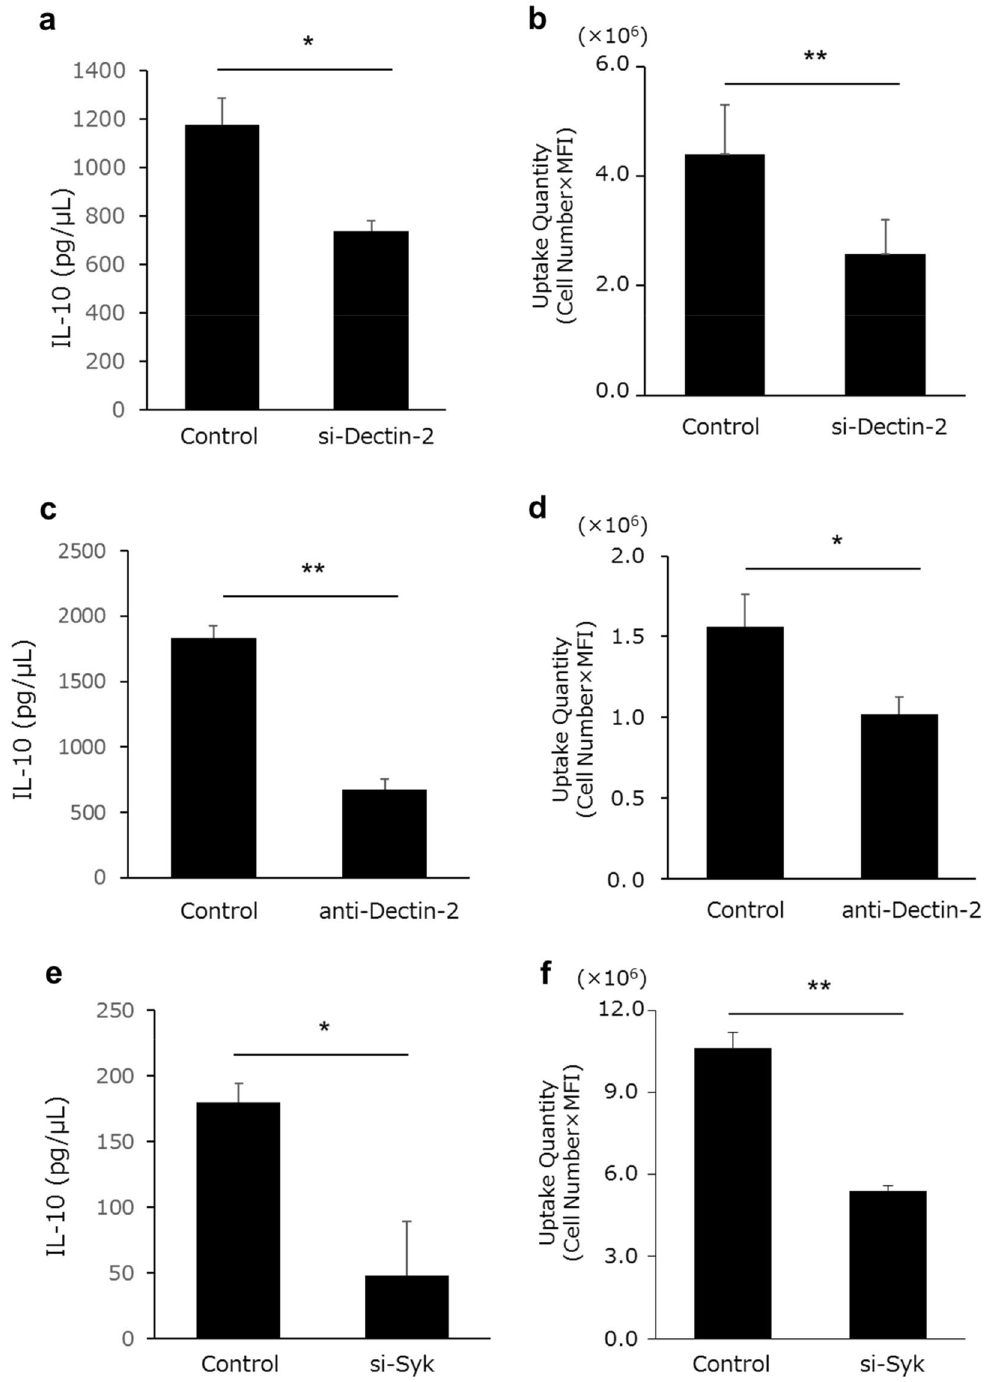
Figure 4. Inhibition of Dectin-2-syk pathway abolishes the effect of KW3110 on IL-10 production. ( a , b ) Dectin-2 knockout RAW 264.7 cells were treated with KW3110 for 24 h. ( a ) IL-10 concentration in the supernatants was measured by ELISA. ( b ) The amount of incorporated KW was measured by flow cytometry. ( c , d ) RAW 264.7 cells were treated with KW3110 in the presence or absence of anti-Dectin-2 antibody for 24 h. ( c ) IL-10 concentration in the supernatants was measured by ELISA. ( d ) The amount of incorporated KW was measured by flow cytometry. ( e , f ) Syk knockout RAW 264.7 cells were treated with KW3110 for 24 h. ( e ) IL-10 concentration in the supernatants was measured by ELISA. ( f ) The amount of incorporated KW was measured by flow cytometry Significant differences were compared to the control group, * p < 0.05, ** p < 0.01. Data are the means ± SD. Data are representative of at least three independent